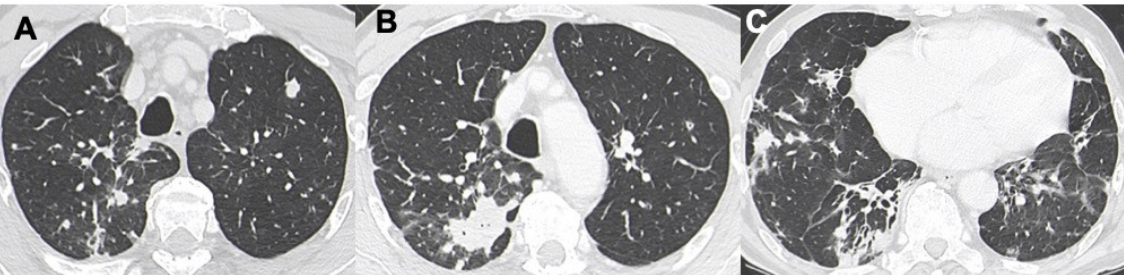
Figure 4. A case of DLBCL with a mixed pattern made of bilateral nodules (in A – C ), interstitial involvement, and consolidations (in ( B )).